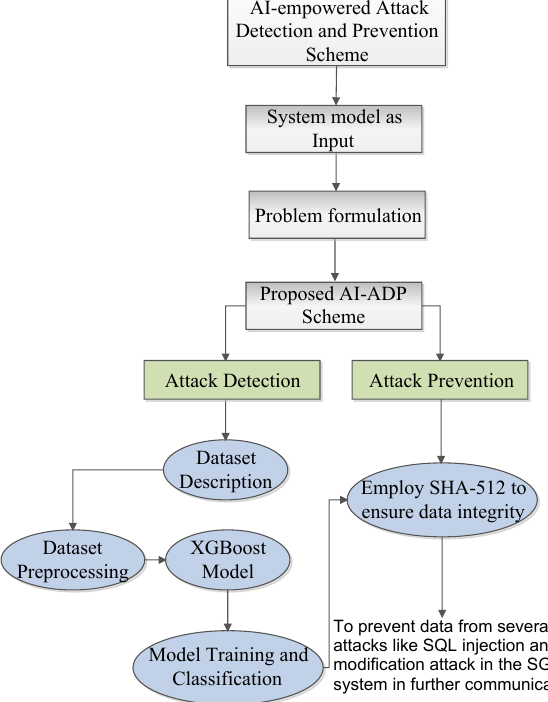
Figure 1. Flow diagram of the proposed AI-ADP